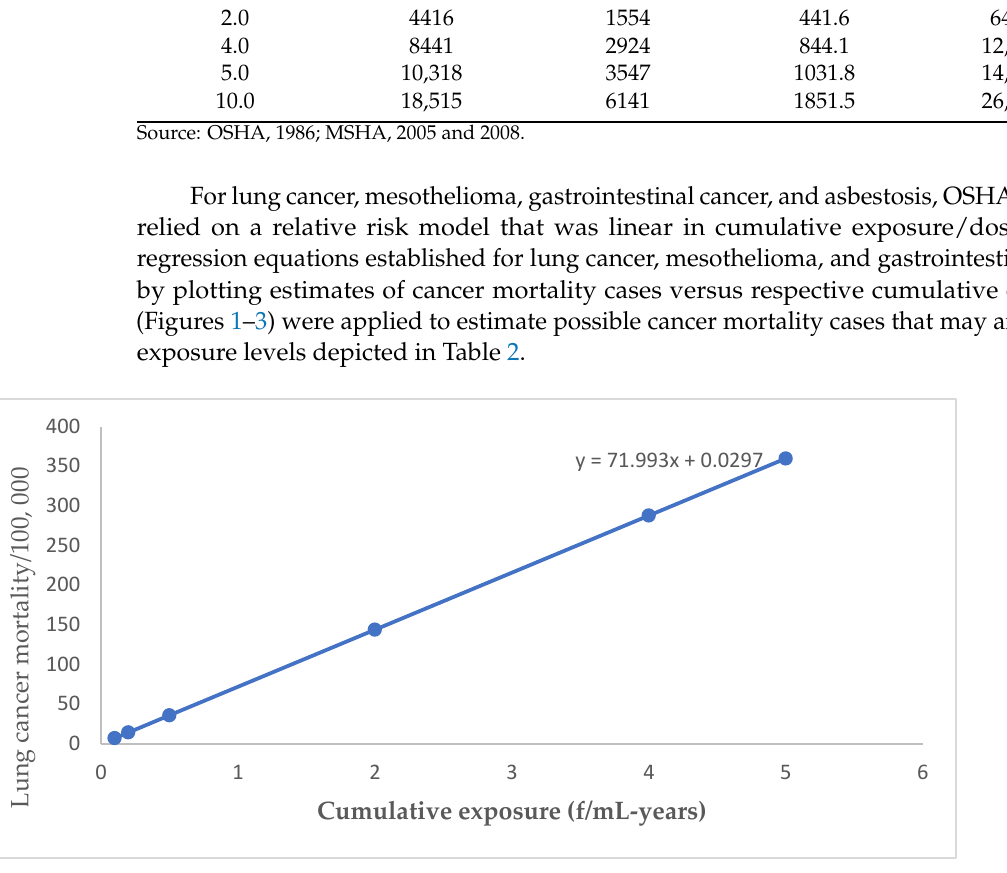
Figure 1. Lung cancer mortality by cumulative exposure linear regression equation.